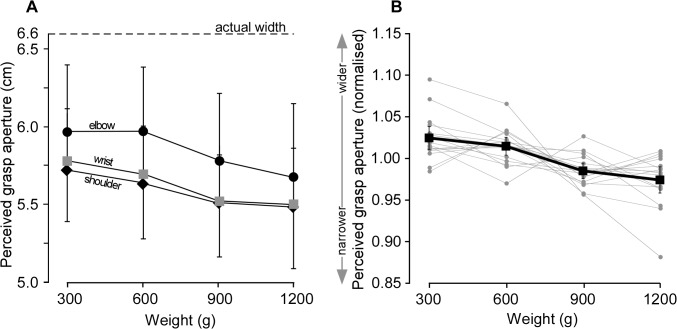
The effect of canister weight on perceived grasp aperture of an unseen lifted object (experiment 1).A, filled symbols represent mean [95% CI] perceived grasp aperture for each of the four test canisters lifted, using movement at the elbow (black circles), wrist (grey squares) and shoulder (black diamonds). The test canisters had the same width (6.6cm) but varied in weight (300–1200 g). Perceived grasp aperture was narrower when heavier canisters were lifted compared to lighter ones (P<0.001). Results are similar with movement at the wrist, elbow or shoulder (P = 0.16). Dashed horizontal line represents the actual canister width (6.6cm) which was consistently underestimated. B, data are presented as ratios normalised to the mean perceived grasp aperture of all four lifted weights for each subject at each joint (perceived grasp aperture/mean perceived grasp aperture of all trials). Individual data are shown as grey circles. Squares show the mean ratio pooled across the three types of movement used to lift the canister [95% CI]. For the pooled data, perceived grasp aperture is significantly narrower (4.8%) when the heavier canisters are lifted compared to the lighter canisters of the same width (P < 0.001).